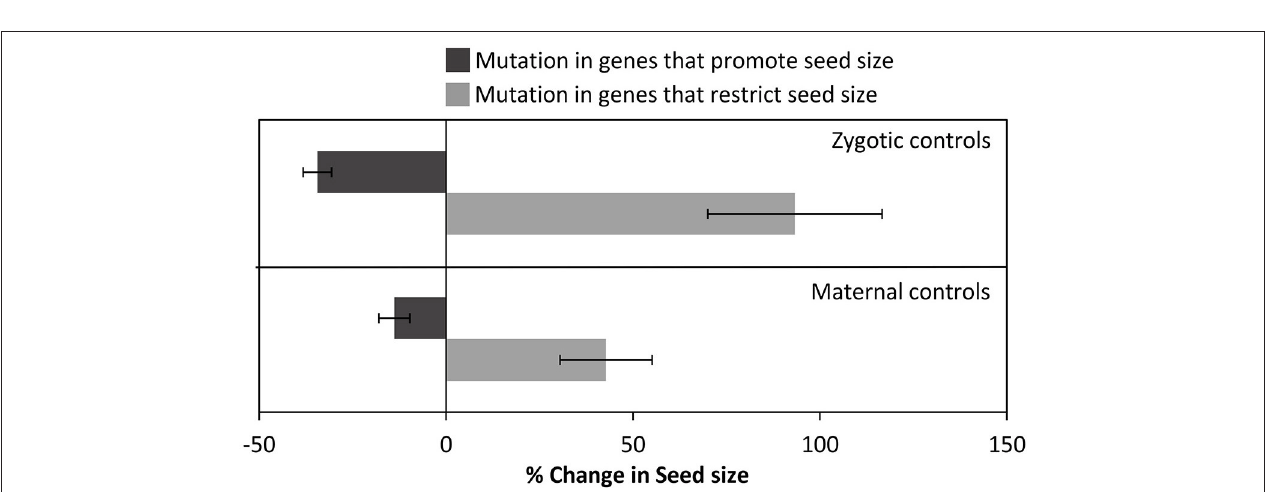
FIGURE 3 | Genetic controls on seed size in Arabidopsis thaliana . The table summarizes mutations in specific genes known to be directly involved in regulating seed size. The bar graph summarizes and differentiates the % change in seed size due to mutations in maternal and zygotic tissues.